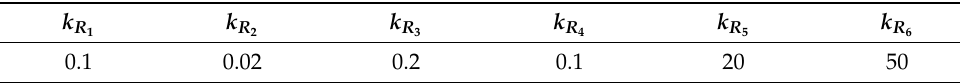
Table 1. Coefficient values of the reward